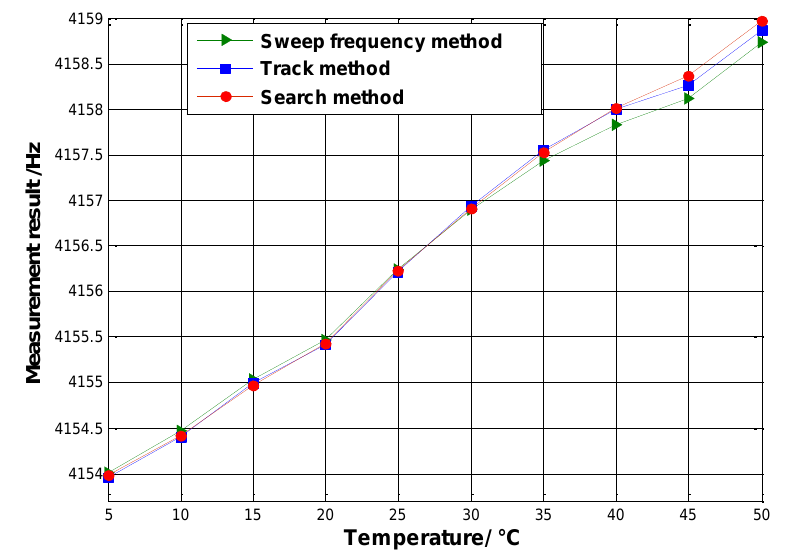
Figure 15. Experimental results of three methods for varying resonant frequency in different